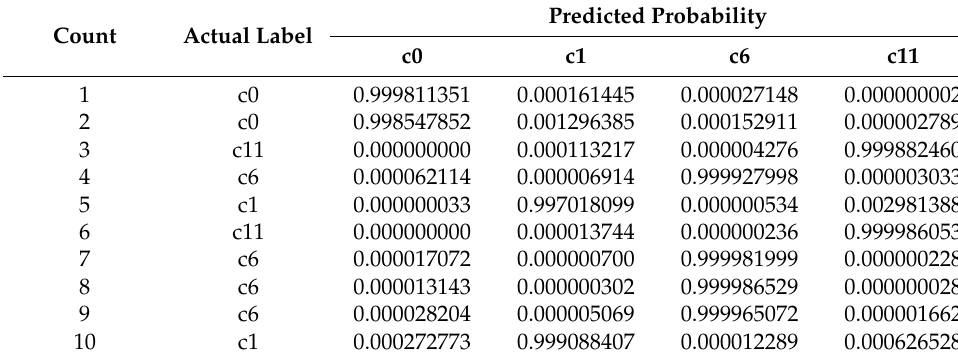
Table 6. Outputs of the second dense